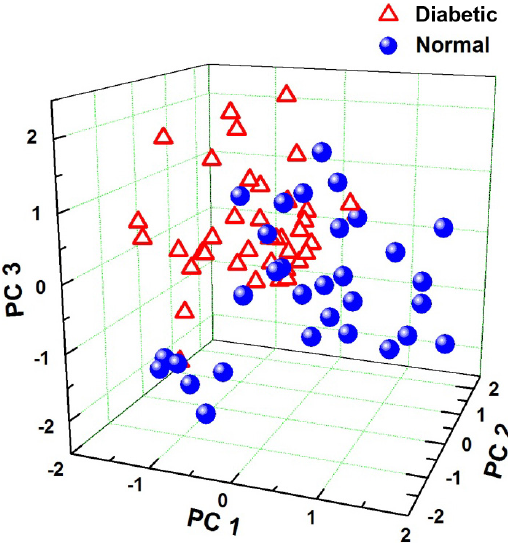
Fig. 3. (Color online) A 3D mapping of the PCA scores for the diabetic group (red triangle) and the normal group (blue circle) (PC1, PC2 and PC3 were chosen as the x – y – z axis).